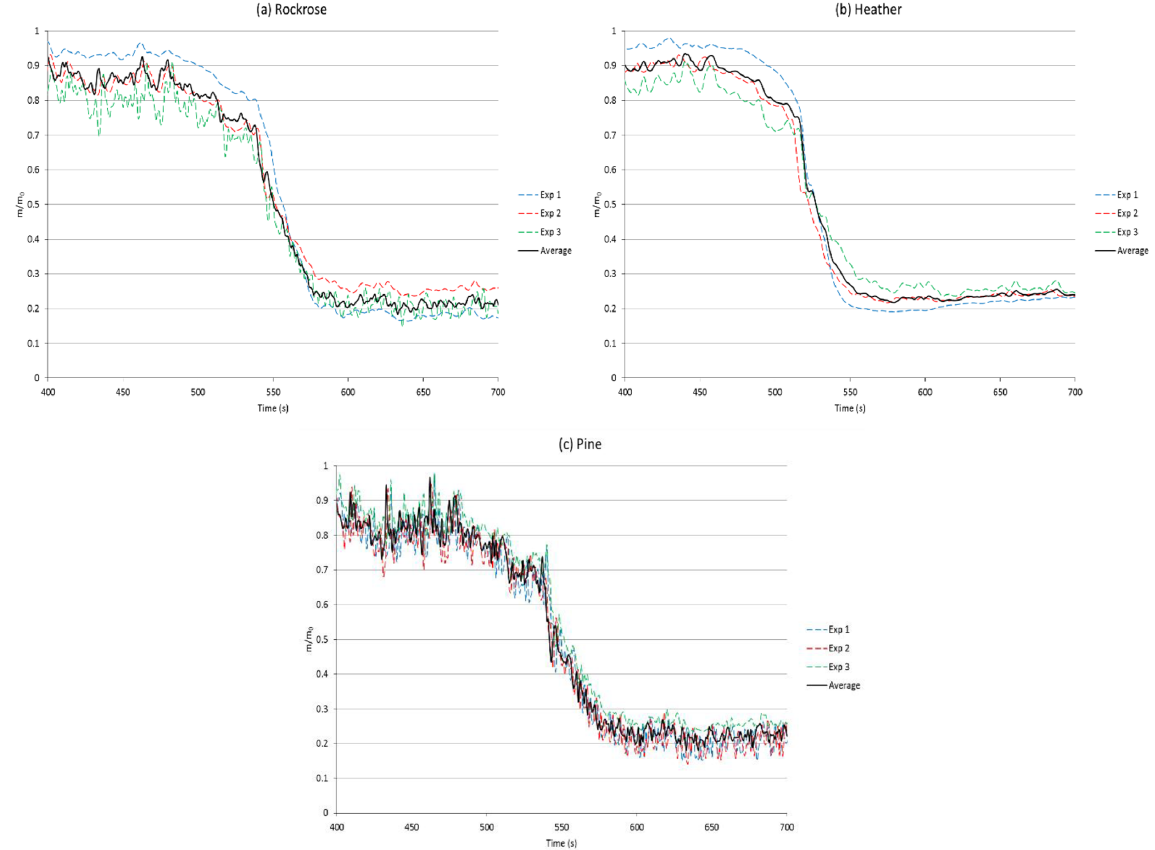
Figure 7. Experimental mass losses obtained on a field scale.